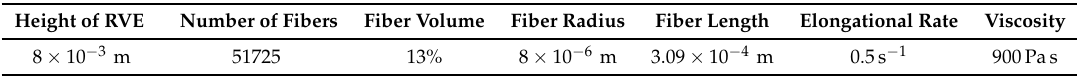
Table 2. Simulation parameters for comparison with the non-lubricated squeeze flow experiment. Height of